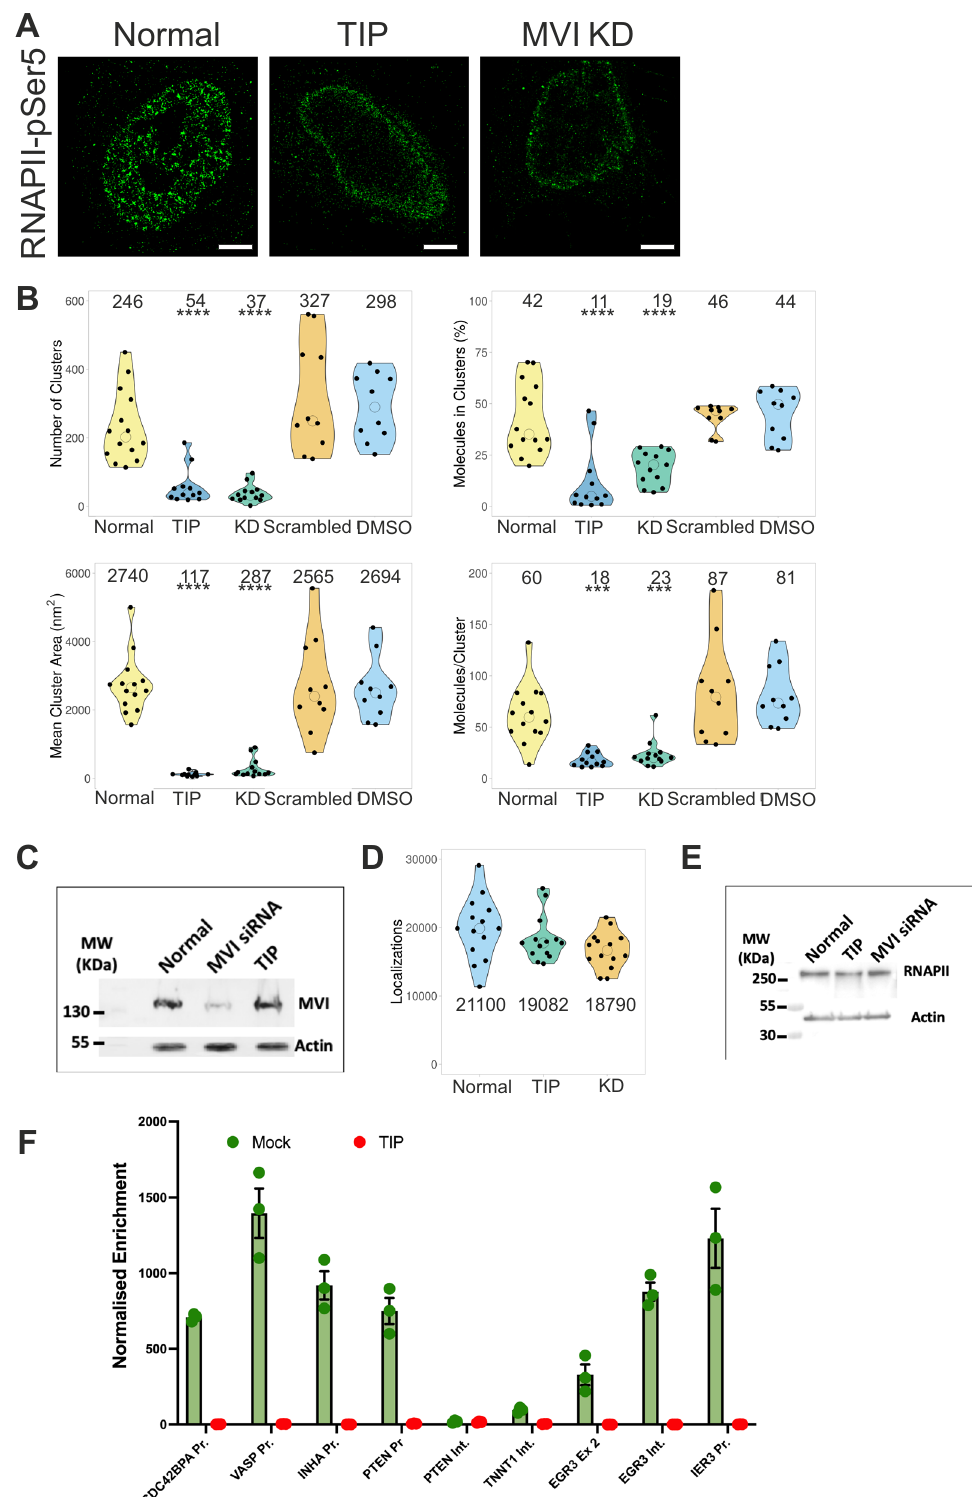
detection in the crowded nuclear environment. Moreover, all populations of RNAPII were visible, compared to solely the pSer5 population in the STORM measurements. We observed pools of spatially con fi ned RNAPII molecules and pools of molecules diffusing freely within the nucleus (Fig. 5C). We determined the diffusion constant for each track by measuring the Mean Squared Displacement (MSD) and then plotted the average diffusion